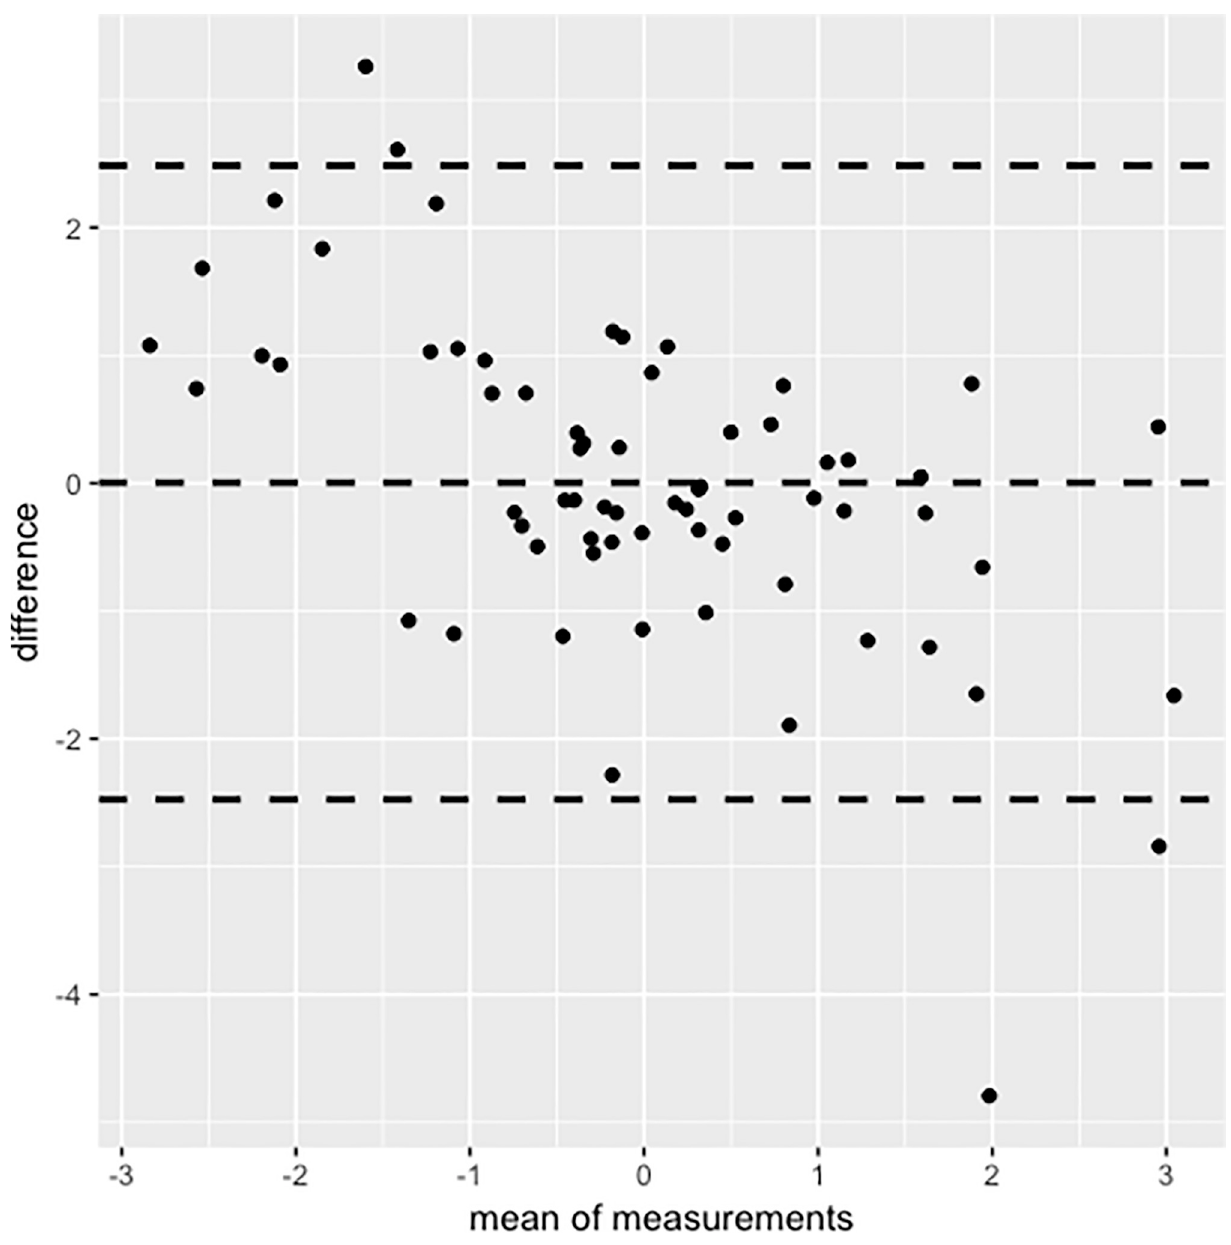
Fig 2. Bland Altman plot for test-retest